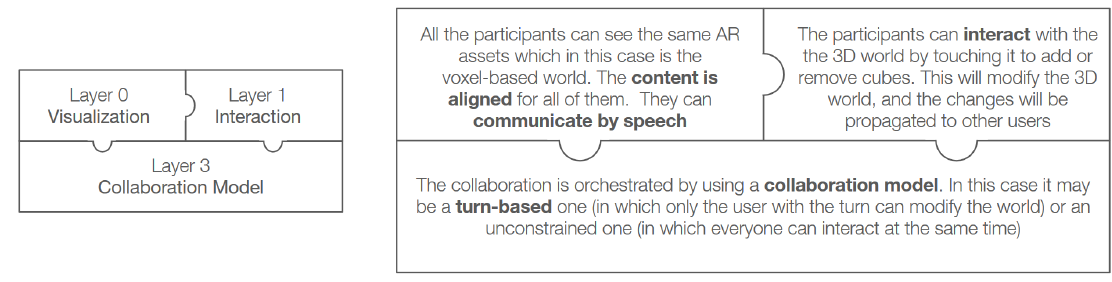
Figure 1. Collaboration